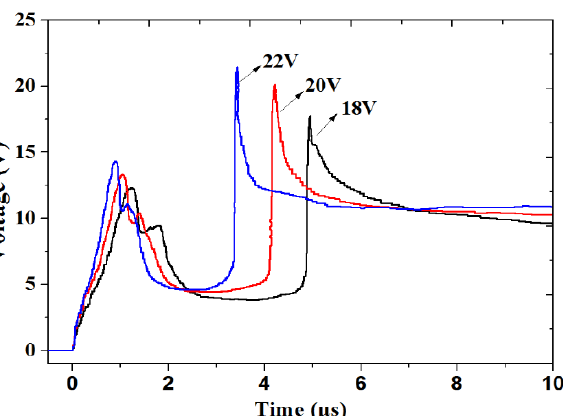
Figure 17. The initiation electric discharge characteristic curve.